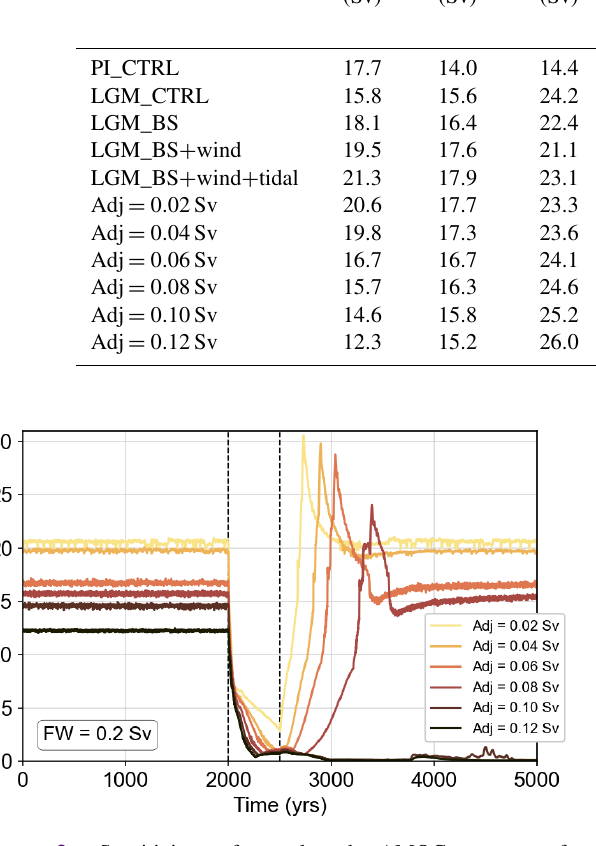
Table 2. Atlantic, Pacific, and Southern Ocean meridional overturning rates (AMOC, PMOC, and SOMOC, respectively), global mean atmospheric surface temperature, mean ocean temperature, and sea ice extent of the Northern and Southern hemispheres (NH and SH, respectively) of all simulations. Run AMOC PMOC SOMOC Mean atmospheric Mean ocean Sea ice (Sv) (Sv) (Sv) surface temperature temperature area, NH/SH ( ◦ C) PI_CTRL